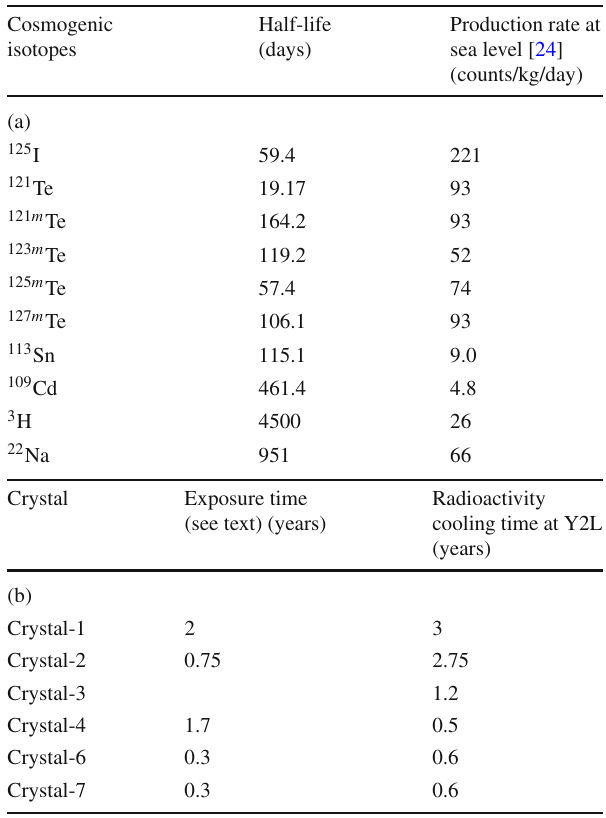
Table 3 Cosmogenic radionuclides in NaI(Tl) crystal (a) and exposure time and radioactivity cooling time at Y2L